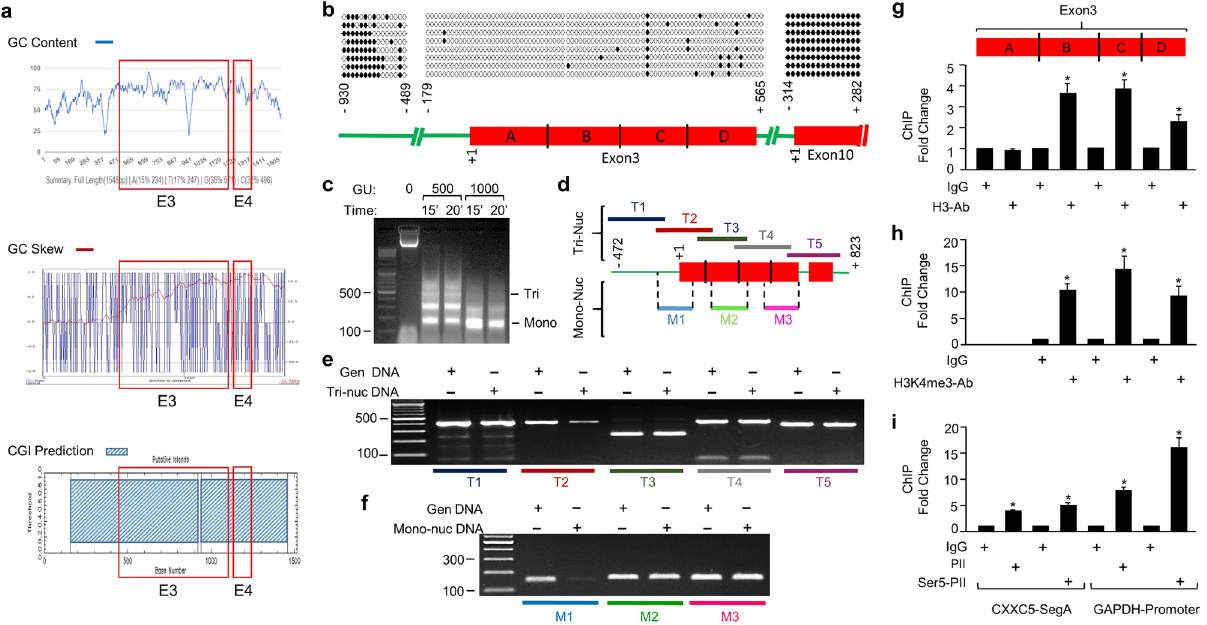
Figure 3. Feature of the CXXC5 region encompassing the promoter of CXXC5 . ( a ) In silico analyses of the nucleotide sequence of the region for G-C content, asymmetric GC distribution, GC skew (GC skew), and the presence of a CpG island (CGI). ( b ) The methylation state of the CXXC5 promoter region (-930 to -489 and -179 through the Exon3; + 1 indicates the beginning of Exon3) together with the 3’-end of Intron9 and Exon10 (− 195 through + 330; + 1 marks the beginning of Exon10) as controls was examined with bisulfite sequencing. Isolated genomic DNA of MCF7 cells was subjected to bisulfite reaction for the conversion of unmethylated cytosine residues to uracil followed by bisulfite PCR. PCR amplicons produced with bisulfite primers were cloned and sequenced. Aligned sequences to the corresponding CXXC5 regions were depicted as a lollipop distribution. Filled circles indicate methylated and empty circles denote unmethylated CpG dinucleotides. ( c ) Nucleosome occupancy at the CXXC5 promoter elements was assessed with Micrococcal Nuclease (MNase) assay. MCF7 cells were fixed, permeabilized, and treated without (0) or with 500 or 1000 gel units (GU) of MNase for 15 or 20 min at 37 °C for chromatin digestion. Isolated DNA was analyzed with agarose gel electrophoresis. ( d ) Schematics of regions subjected to PCR. Isolated DNA fragments corresponding to ( e ) tri-nucleosomal (T1- 5) and ( f ) mono-nucleosomal (M1-3) DNA were subjected to PCR using region-specific primer pairs. ( g – i ) ChIP analysis of Exon3. Following chromatin digestion of MCF7 cells by the use of MNase were subjected to ChIP using species-specific IgG, an antibody specific to total H3 ( g ) or H3K4me3 ( h ). Isolated DNA following precipitation with Protein A/G conjugated magnetic beads was subjected to qPCR using region-specific primer sets. Asterisk (*) denotes significant changes depicted as fold change compared to IgG. ( i ) MCF7 cells fixed, lysed, and sonicated were subjected to ChIP using IgG, PolII, or ser5-phosphorylated PolII antibody followed by precipitation with Protein A/G conjugated magnetic beads. DNA samples were then used for qPCR with primer sets specific to Segment A or the promoter of GAPDH as control. Shown are the mean ± SE of three independent experiments performed in triplicate. Significant differences depicted with an asterisk (*) are shown as fold change compared to